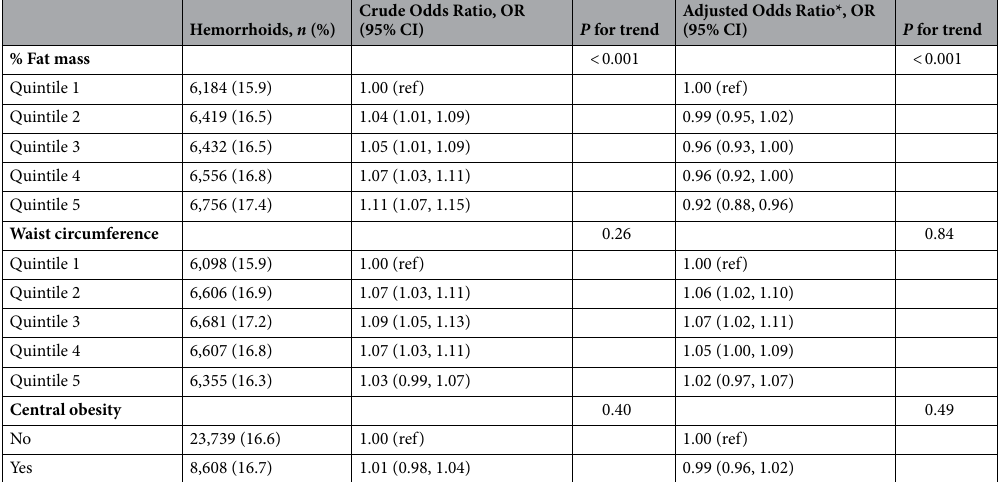
Table 3. Association between alternative markers of adiposity and the prevalence of hemorrhoidal disease. * Adjusted models included age (20–29, 30–39, 40–49, 50–59, and 60–70 years), sex, year of visit, center, education (≤ 12 and > 12 years), physical activity (low, moderate, and high), smoking (never, former, and current), daily alcohol intake (none, < 5 g/day, 5 to < 20 g/day, and ≥ 20 g/day), and presence of diabetes, hypertension, and dyslipidemia, plus one of the following markers of excess adiposity: % fat mass % categorized in quintiles (< 20.34, 20.35–23.75, 23.75–27.08, 27.08–31.58, ≥ 31.58%), waist circumference categorized in quintiles (< 74.7, 74.7–80.5, 80.5–85.1, 85.2–90.5, and ≥ 90.5 cm), and central obesity (no vs.